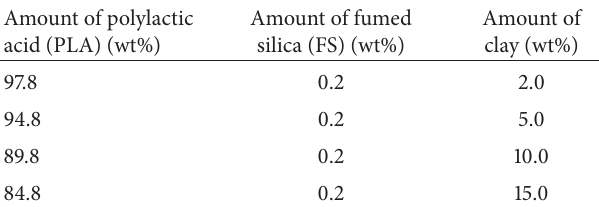
Table 1: Preparation of PLA/FS/clay (1.28E)